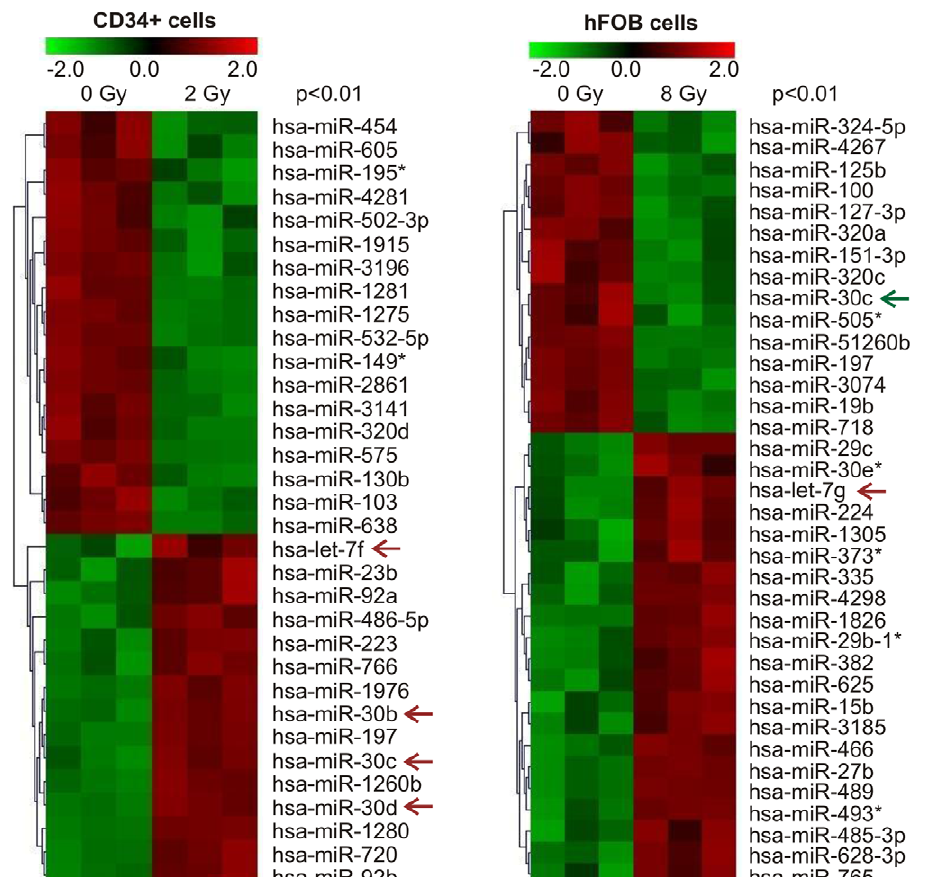
Figure 1. Differentially expressed miRNAs in human hematopoietic and osteoblast cells following exposure to c - radiation. Human hematopoietic CD34 + cells and fetal osteoblastic cell line (hFOB) cells were exposed to 2 Gy or 8 Gy of c - radiation, respectively. miRNA microarray analysis was performed by LC Sciences Co. (Houston, Texas) in triplicate. Significant increases or decreases in miRNA expression in irradiated vs. non- irradiated control samples were strictly cut off at p , 0.01. The three columns represent three biological replicates from each sample. Colors represent log2 values from 2 2.0 to + 2.0. Arrows indicate miRNAs that either increased (red) or decreased (green) after radiation. *: miRNA expressed at low levels.